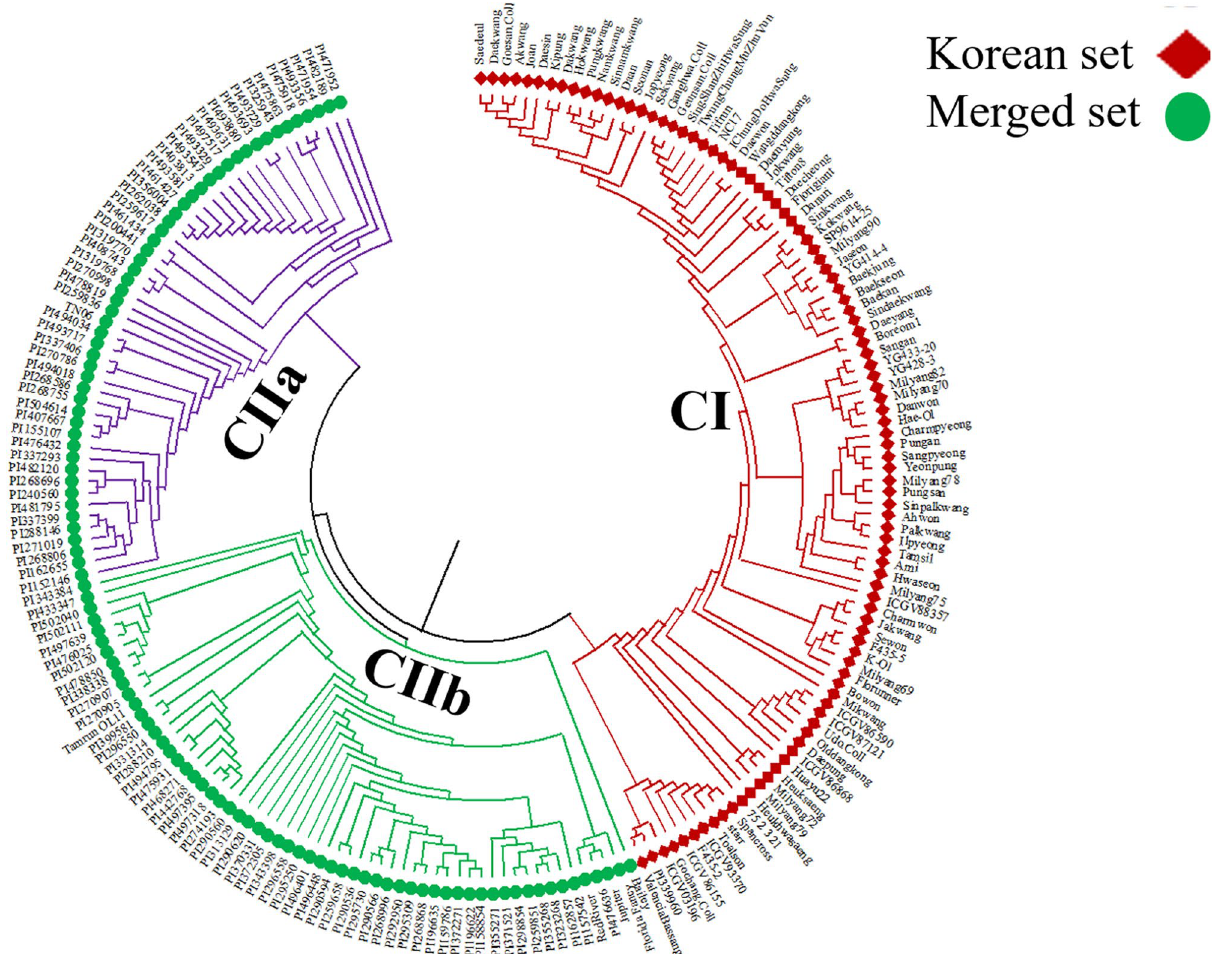
Figure 5. Phylogenetic tree of Merge set of peanut genotypes (n = 207) constructed using MEGA X software (http:// www. megas oftwa re. net/.) with the neighbor-joining method 44 . These genotypes were clustered into two major clusters. The second cluster was subdivided into CIIa and CII, with each colored branch representing respective cluster (CI, red; CIIa, purple; CIIb, green).